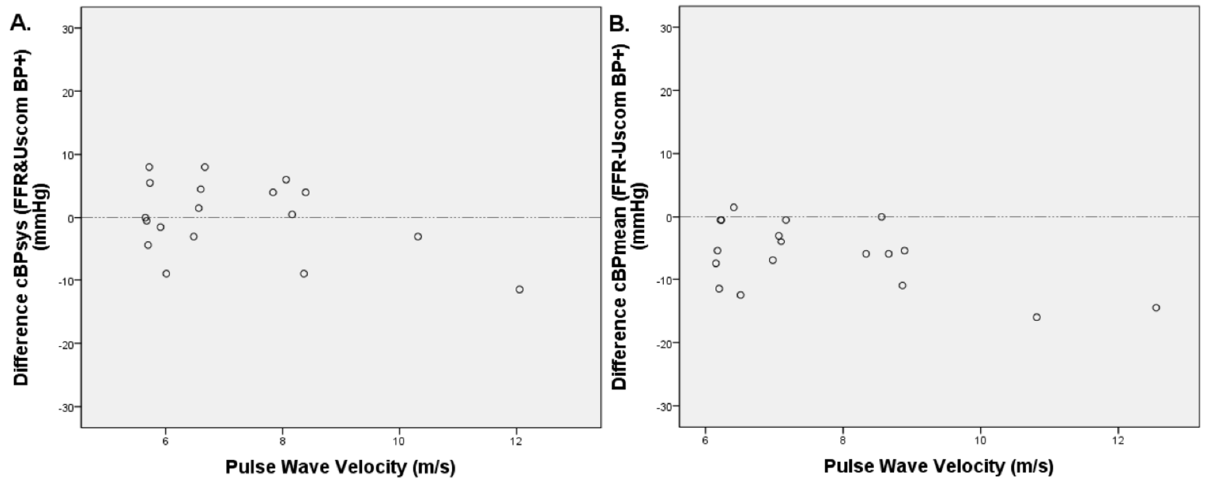
Figure 8. Dispersion graph between aorto-brachial pulse wave velocity and the difference of invasive and non ‐ invasive cBPsys ( A ) and cBPmean ( B ) ( n = 18).